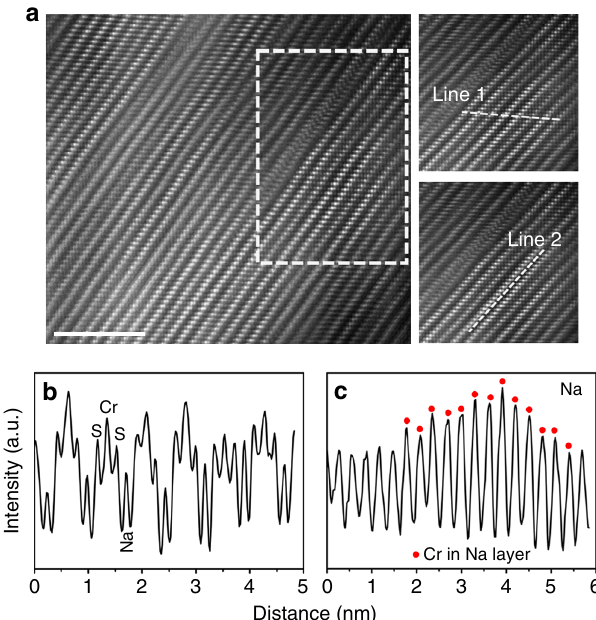
Fig. 3 Atomic structure of NaCrS 2 after charge. a HAADF-STEM image of the desodiated particle (Na 1 − x CrS 2 : x = 0.5 calculated from capacity), scale bar 5 nm. b , c The contrast pro fi les of the regions scanned by line 1 (Cr, S, and Na ions columns) and 2 (Na columns), respectively. ( Red circle represents Cr ion in the Na peaks emerge at 2.85/2.05 V in the fi rst cycle, which are close to the galvanostatic charge/discharge voltage plateaus in the fi rst